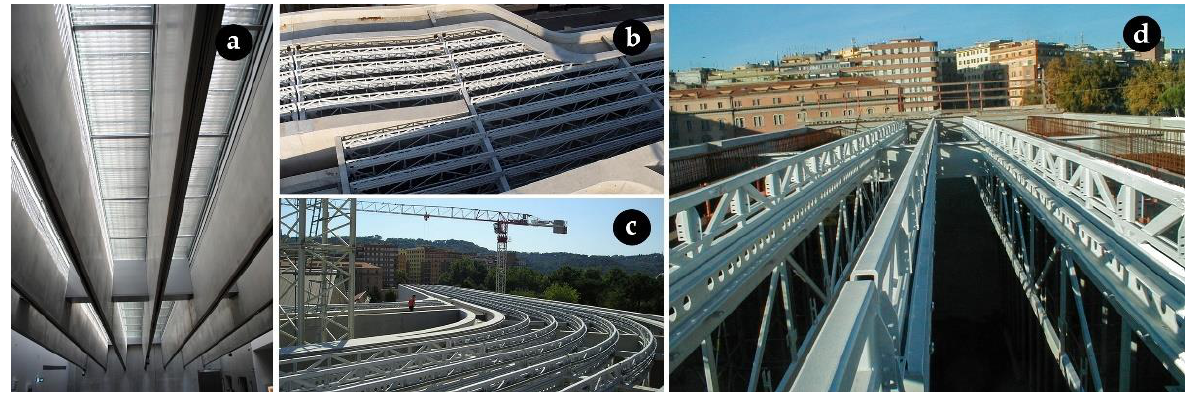
Figure 11. MAXXI, Rome (2010). ( a ) The roof from the inside (ph. Cardellicchio, 2018). ( b – d ) Construction pictures of the roof showing the metal blades (courtesy: MAXXI).